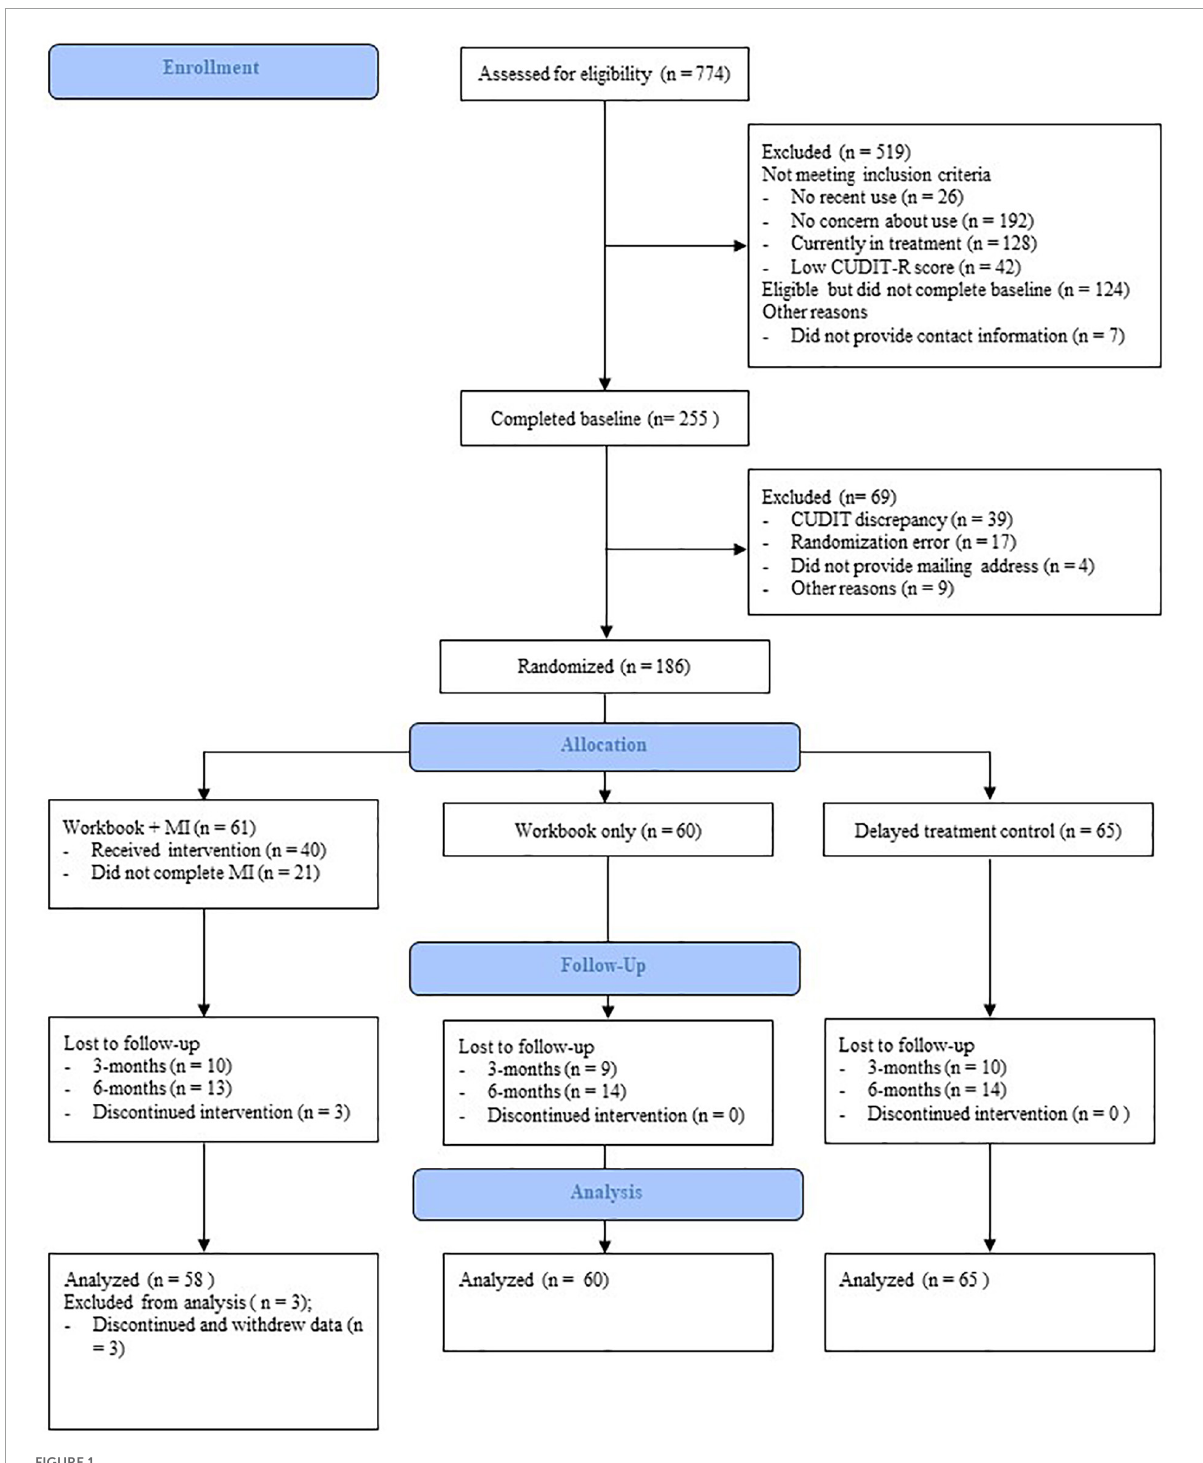
FIGURE1 Consolidated Standards of Reporting Trials (CONSORT) style flow-chart of participant recruitment and retention.